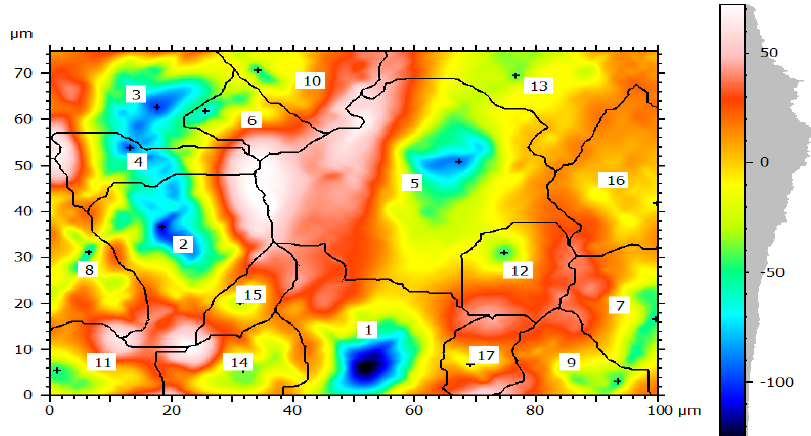
Figure 9. Corrosion morphology of watershed segmentation per particle.